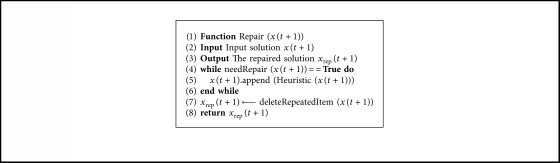
 Repair algorithm.